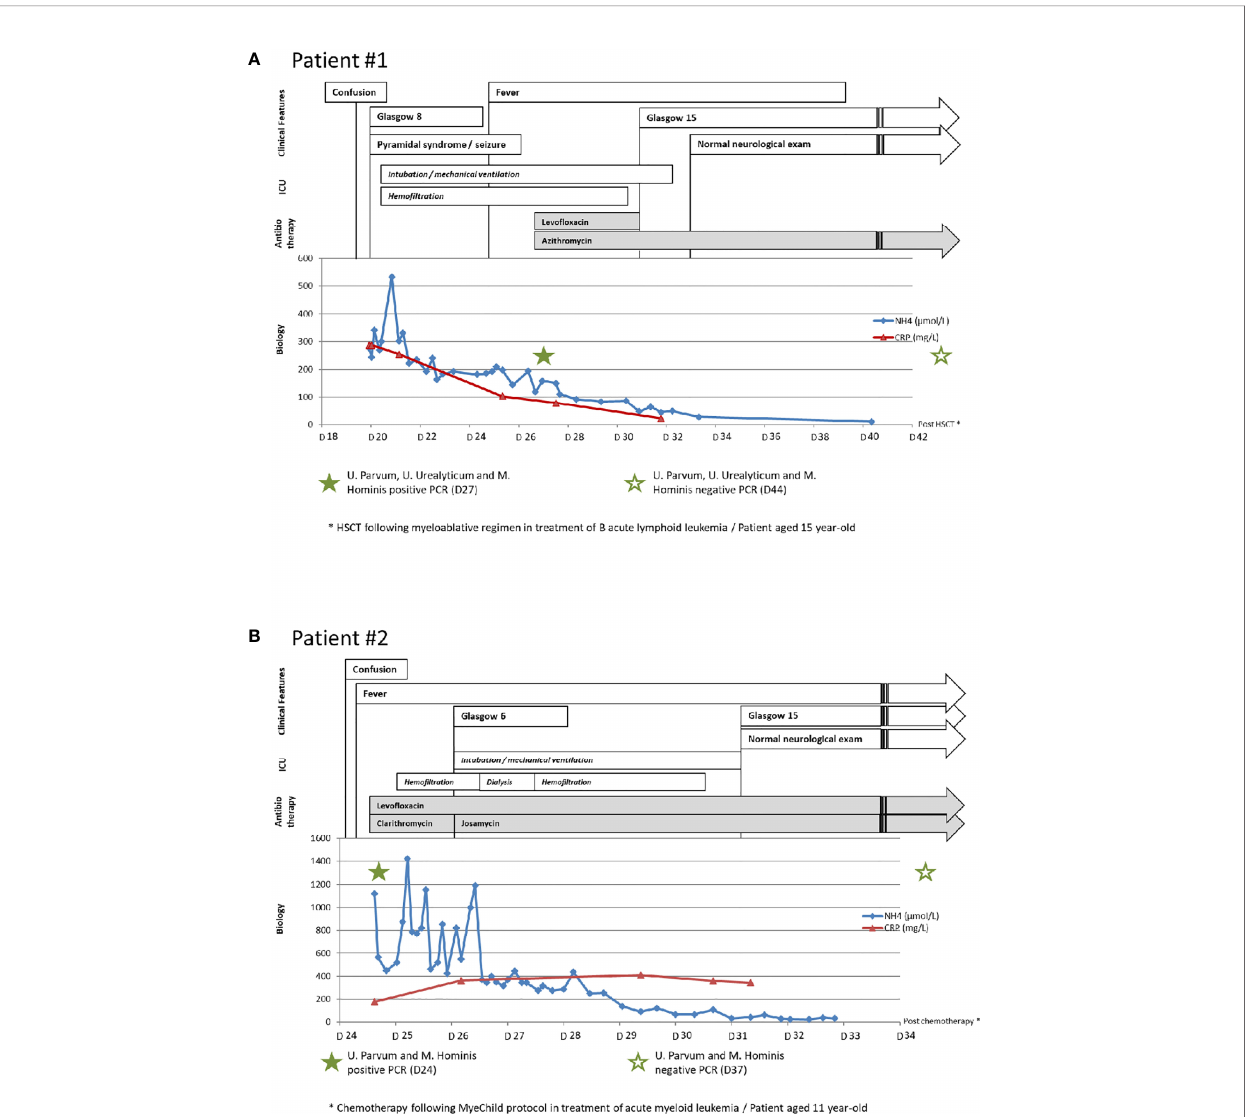
FIGURE 1 | Clinical, biological, and imaging features and treatment of patients. (A) Clinical, biological, and imaging features and treatment of patient #1. (B) Clinical, biological, and imaging features and treatment of patient #2. HSCT, hematopoietic stem cell